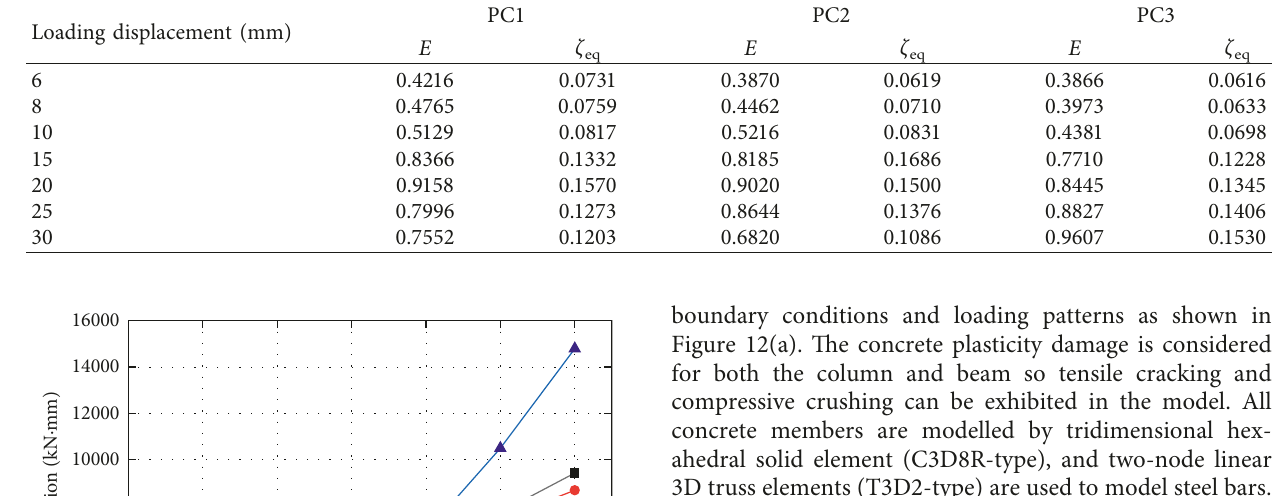
Table 1: Energy dissipation coefficient ( E ) and equivalent damping coefficient ratio ζ